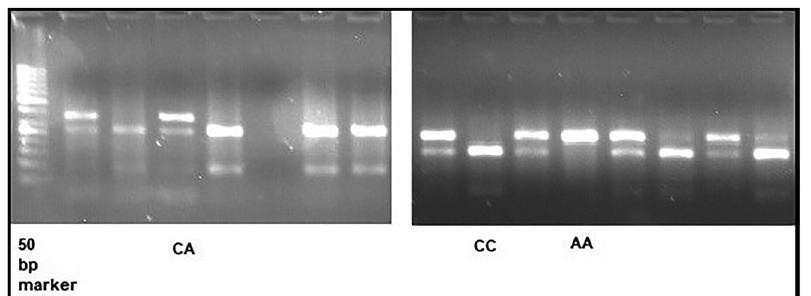
Figure 1: Agarose gel electrophoresis images of the PIK3CA (C>A) fragments.